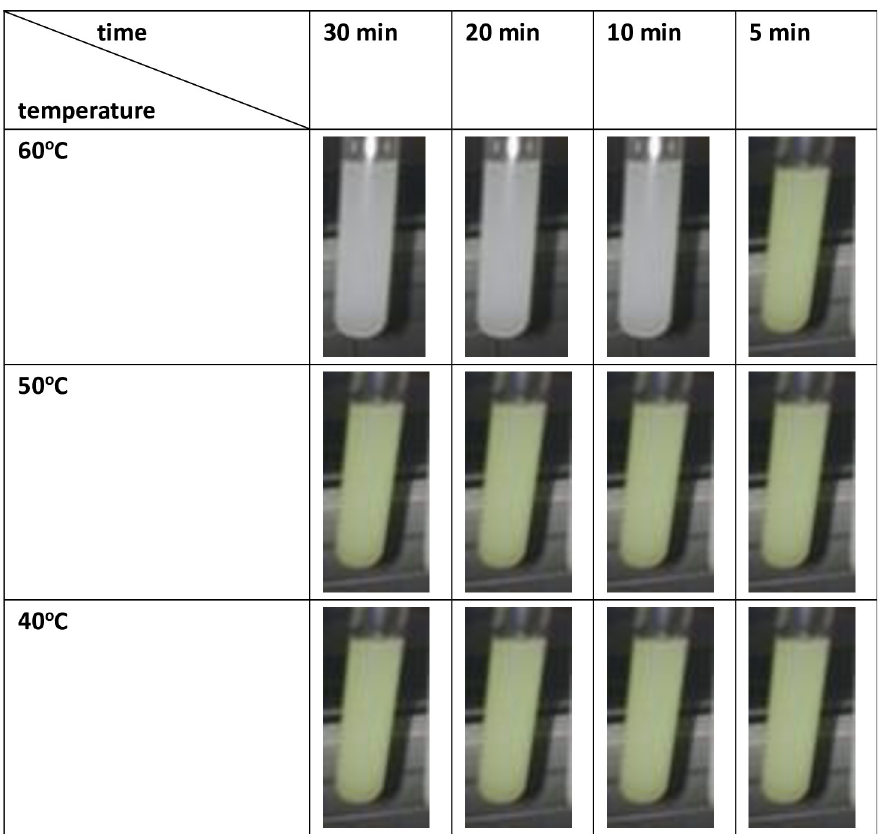
Fig 8. The effect of VFD-pasteurization with different processing times (5–30 min) and temperatures (40–60˚C) on raw milk (VFD Mode: confined mode; VFD rotation speed: 9000 rpm; VFD tilt angle: 45˚).